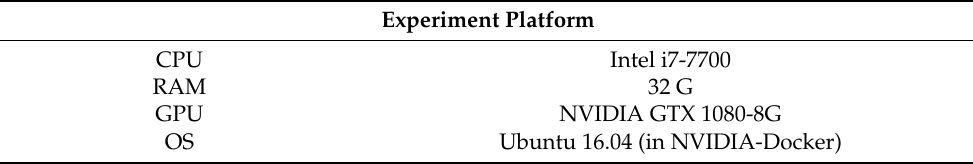
Table 5. Experiment platform specifications.